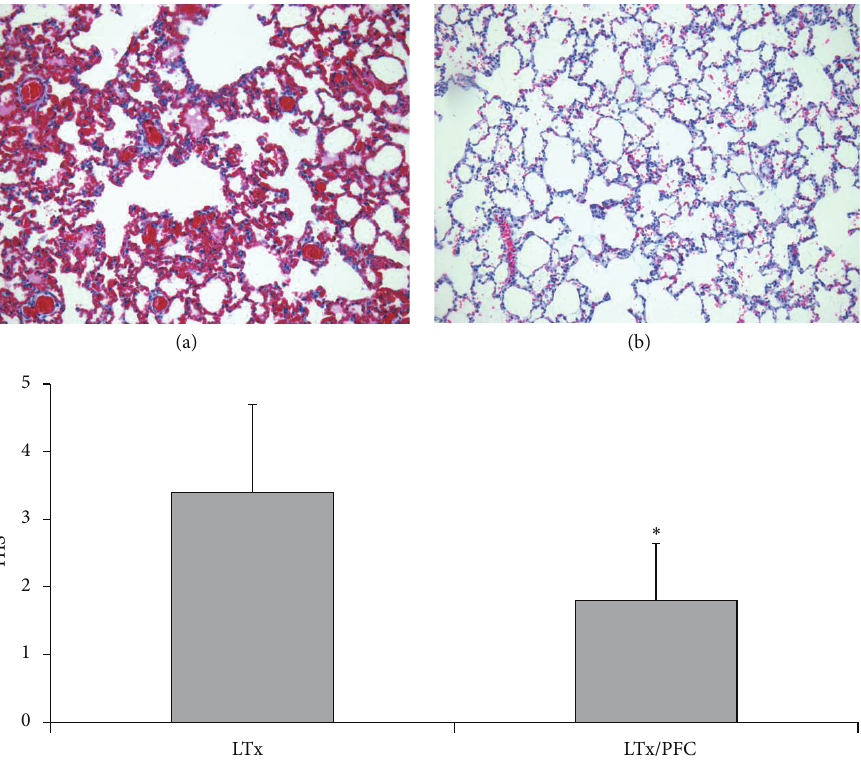
Figure 5: Histological score (HIS) after the lung transplantation. Lung injury was characterized by perivascular edema, intra-alveolar hemorrhage, and interstitial and intra-alveolar leukocyte infiltration in the LTx group (a) compared with the LTx/PFC group (b). The HIS demonstrated significantly more lung injury in the Ltx group ( ∗ 𝑃 < 0.05 ) (200x